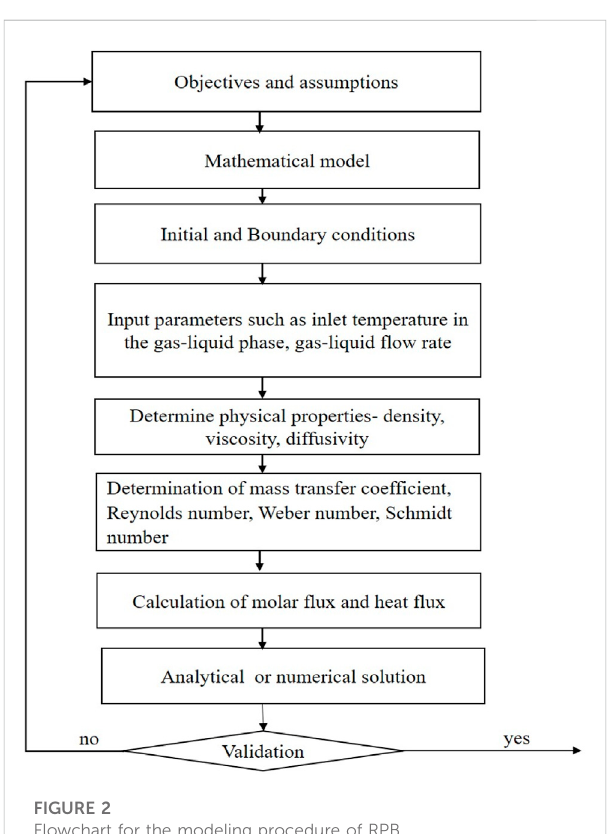
FIGURE 2 Flowchart for the modeling procedure of